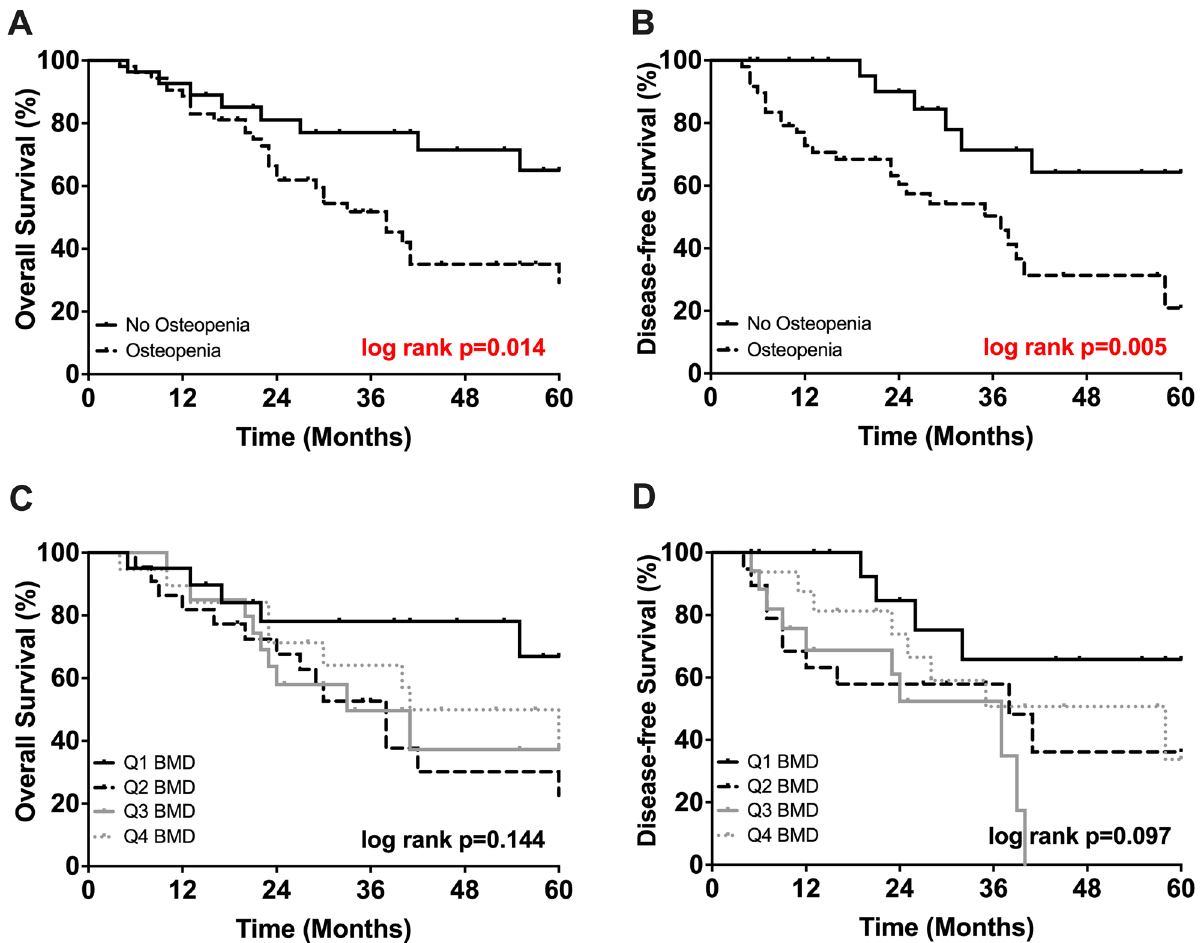
Figure 3. ( A ) 5-year survival of osteopenic and non-osteopenic patients. ( B ) Disease-free survival of osteopenic and non osteopenic patients. ( C ) 5-year survival divided by quartiles of bone density. ( D ) Disease- free divided by quartiles of bone